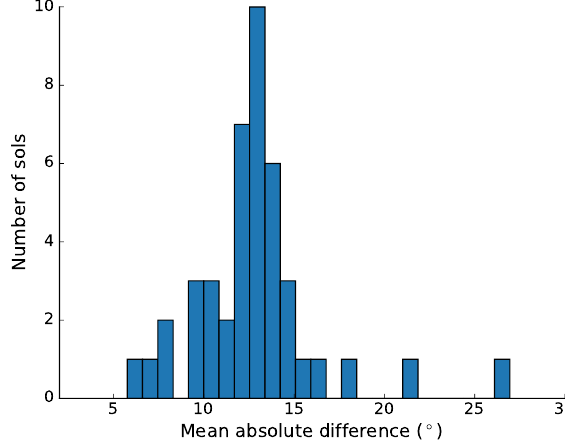
Figure 22. Mean absolute difference of the angles during sols